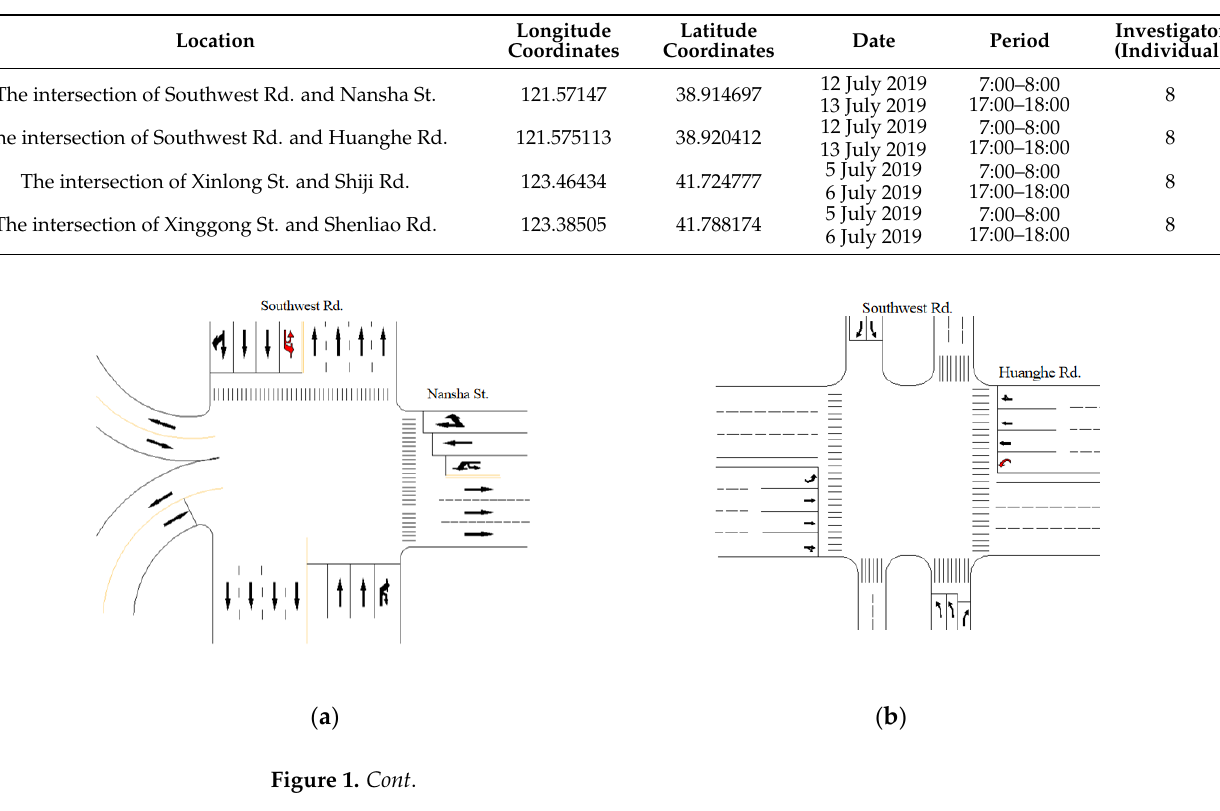
( d ) Figure 1. Road conditions at the four intersections. ( a ) The intersection of Southwest Rd. and Nansha St. (inside). ( b ) The intersection of Southwest Rd.and Huanghe Rd. (inside). ( c ) The intersection of Xinggong St. and Shenliao Rd. (outside). ( d ) The intersection of Xinlong St. and Shiji Rd. (outside). 3. Methodology 3.1. Analysis and of Influential Relationship Taking the entrance lanes of two straight-going lanes as an example, four conditions are selected as the number of straight-going vehicles as follows: 600, 750, 900, and 1050 veh/h. With the help of MATLAB, the influence of the different numbers of left-turn vehi- cles and lengths of weaving sections on the delay of the left-turn lane inside or outside of the entrance lane is fitted and discussed. The relation curve is shown in Figure 2. The three straight-going lanes have similar influential relationships.